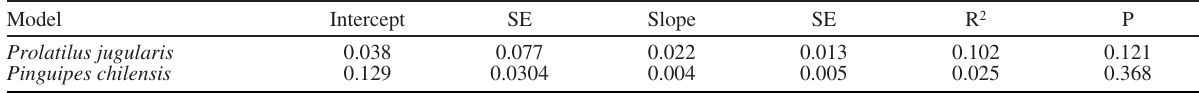
Table 5. – Summary of main results of least square linear regression between Pearre’s trophic niche breadth and standard length of each larval sandperch collected on the coast of El Quisco Bay, Chile.